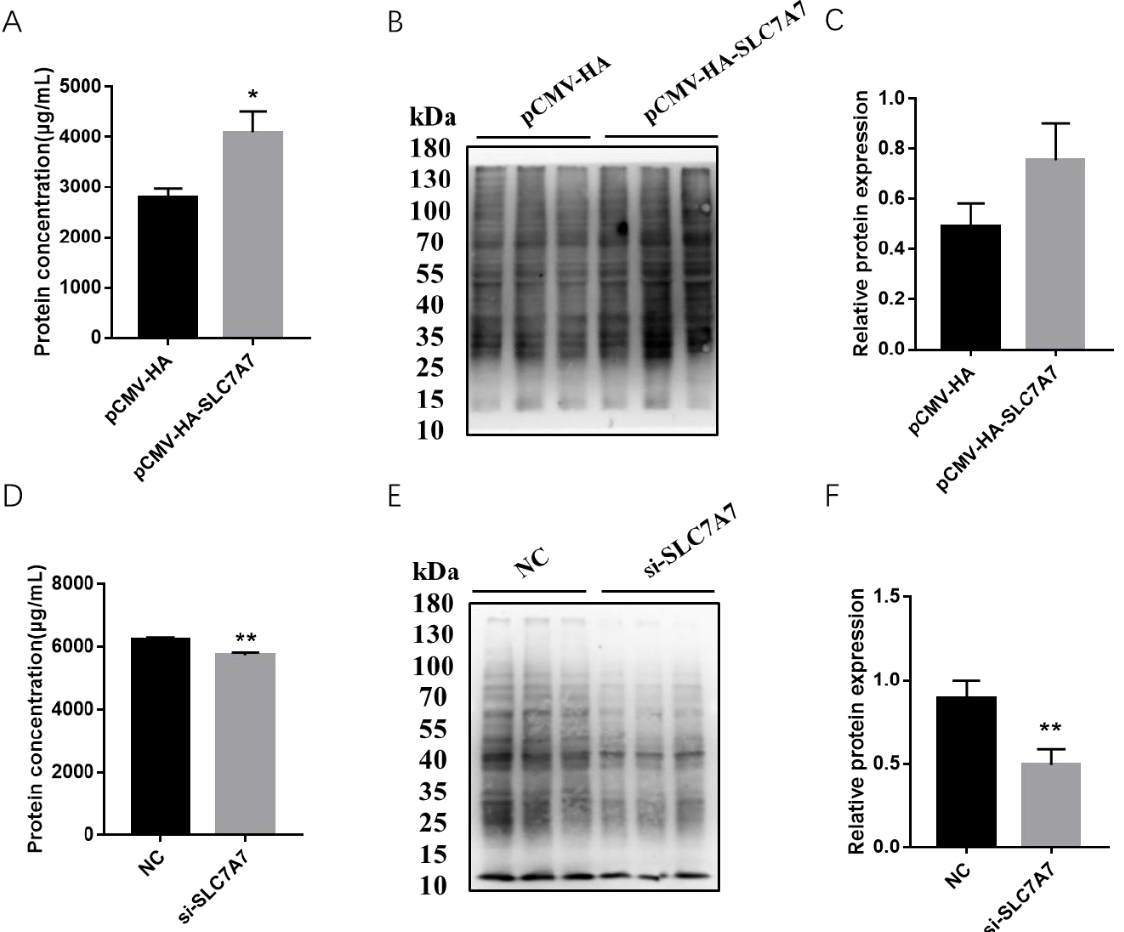
Figure 5. Overexpression and interference of SLC7A7 affect cell protein synthesis. ( A ) Total cell protein after overexpression of SLC7A7 ; ( B ) the effect of overexpression of SLC7A7 on the rate of protein synthesis; ( C ) protein quantification of puromycin; ( D ) total cell protein after interfering of SLC7A7 ; ( E ) the effect of interfering of SLC7A7 on the rate of protein synthesis; ( F ) protein quantification of puromycin. *, ** indicate significant difference at p < 0.05 and p < 0.01, respectively.